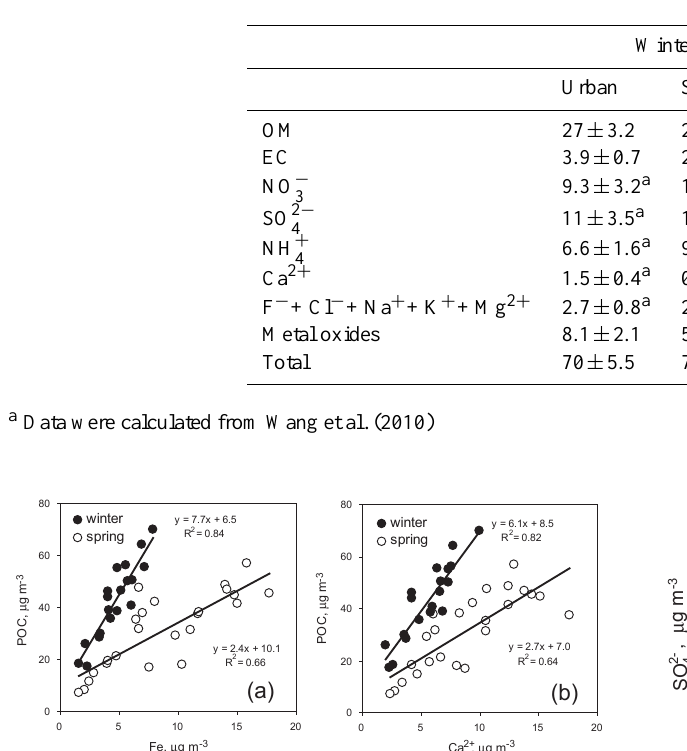
Table 5. Percentages of major species in particle mass, %.